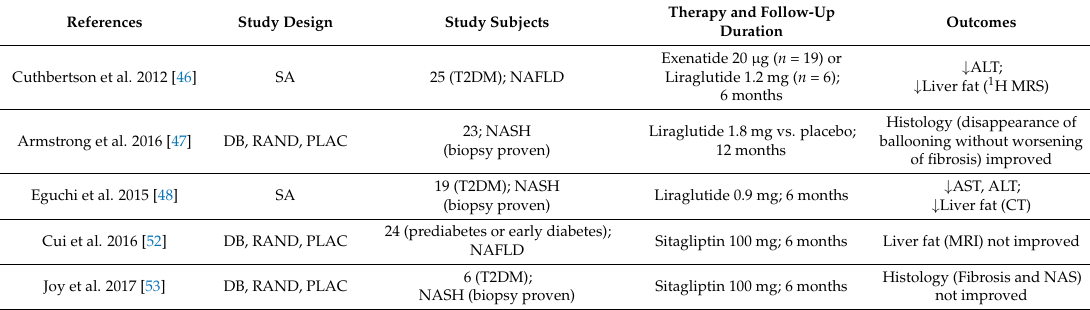
Table 1. Summary of clinical trials of GLP-1RA or DPP-4 inhibitors involving NAFLD/NASH